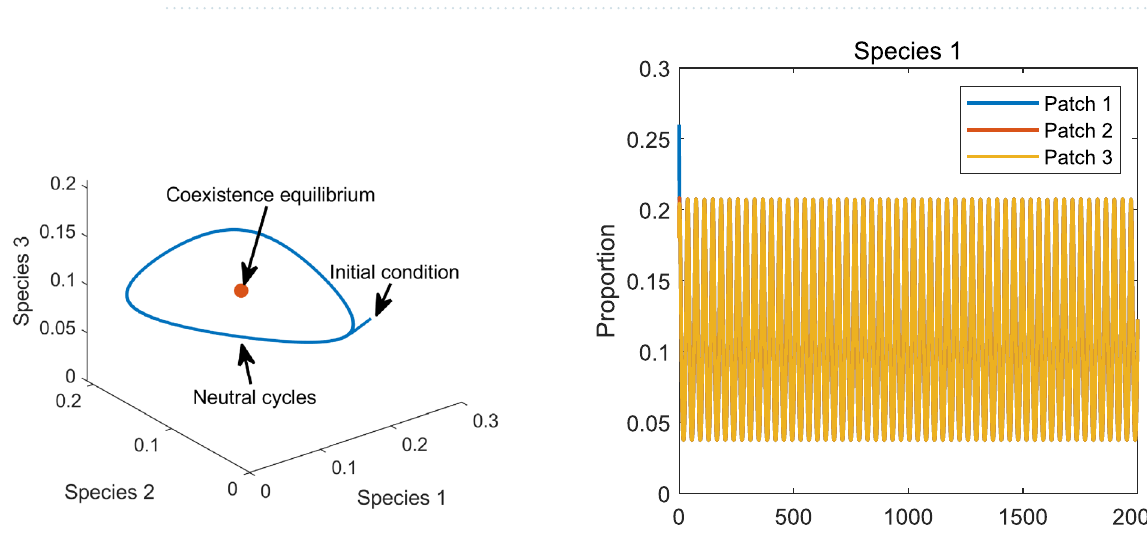
Figure 5. Left: Dynamics of the metapopulation model in Fig. 3 for patches 1 and 3 showing asymptotic stability of the coexistence equilibrium. Right: The time evolution of the proportion of species 1 in the three patches.